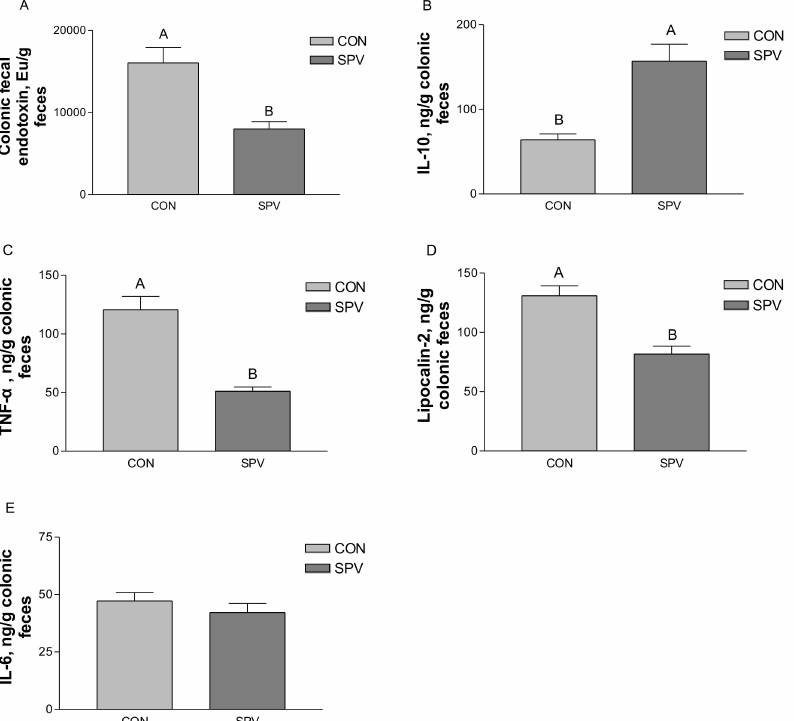
Figure 2. E ff ect of sweet potato vine supplementation on endotoxin ( A ), IL-10 ( B ), TNF- α ( C ), lipocalin-2 ( D ), and IL-6 ( E ) in colonic digesta of Meishan gilt. Values are mean ± SEM (n = 8). CON, gilts fed the basal diet; SPV, gilts fed basal diet with sweet potato vine. A, B Means not sharing identical superscripts in the same figure are significantly di ff erent ( p <